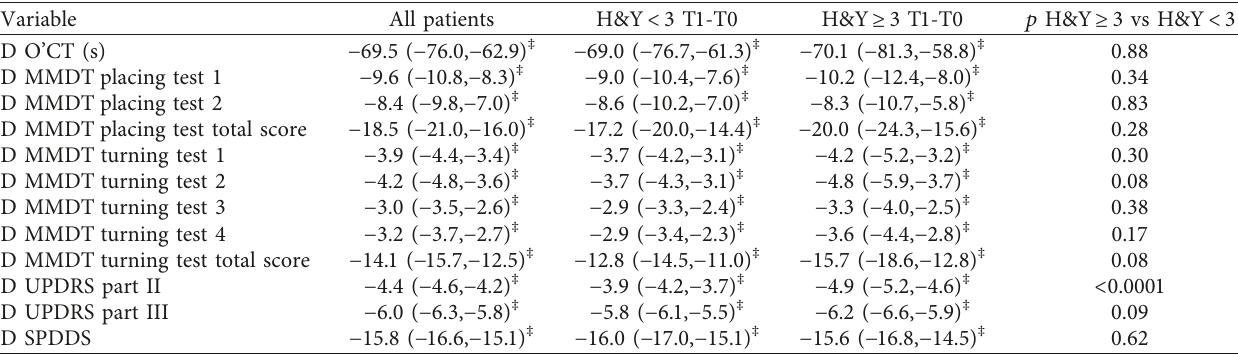
Table 3: Differences (values at discharge—values at admission) of the outcome